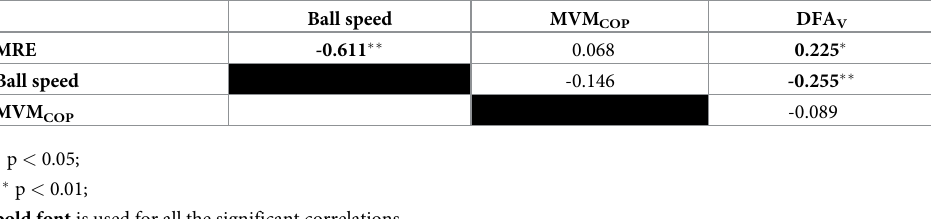
bold font is used for all the significant correlations.